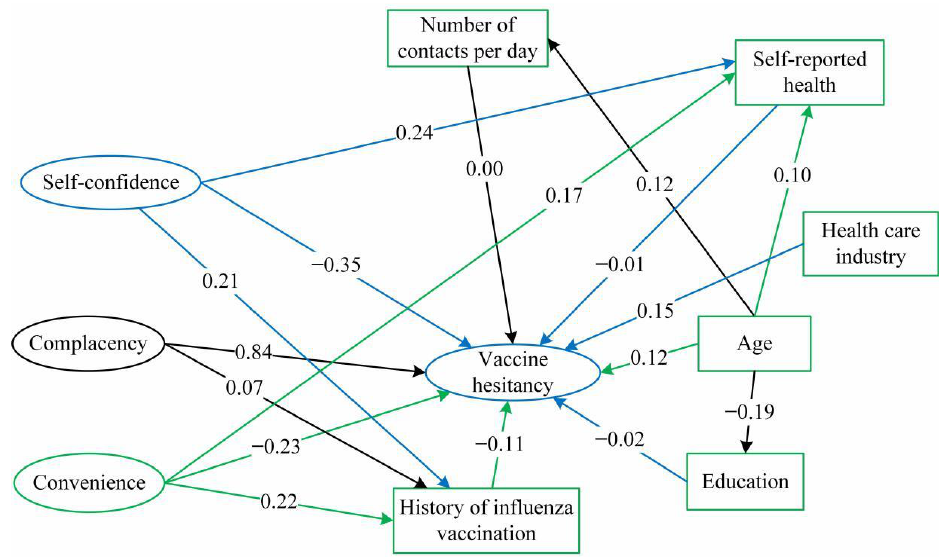
Figure 5. Structural equation model of vaccine hesitancy among adults.